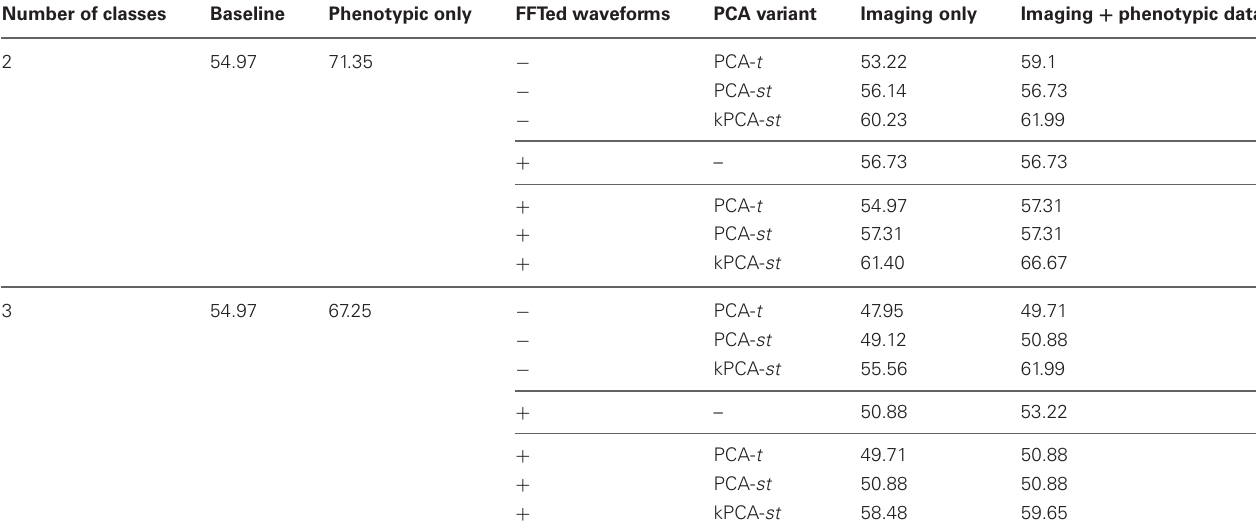
Table 3 | Two and three class classification accuracies on the holdout set , where the reduced features were obtained by performing FFT and/or PCA- t , PCA- st , and kPCA- st on the averaged imaging data. Number of